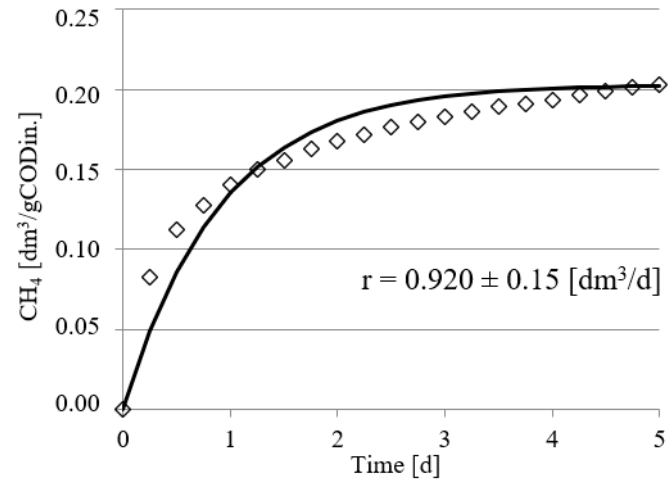
Figure 5. Course of methane fermentation in series 4.